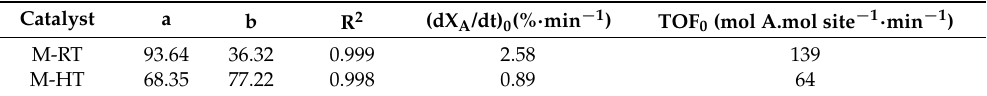
Table 5. Parameters of the hyperbolic fits, y = ax/(x + b), for ethyl acetate (A) conversion ( y ) as a function of time ( x ), and the initial turnover frequency (TOF 0 ) values of the catalysts.